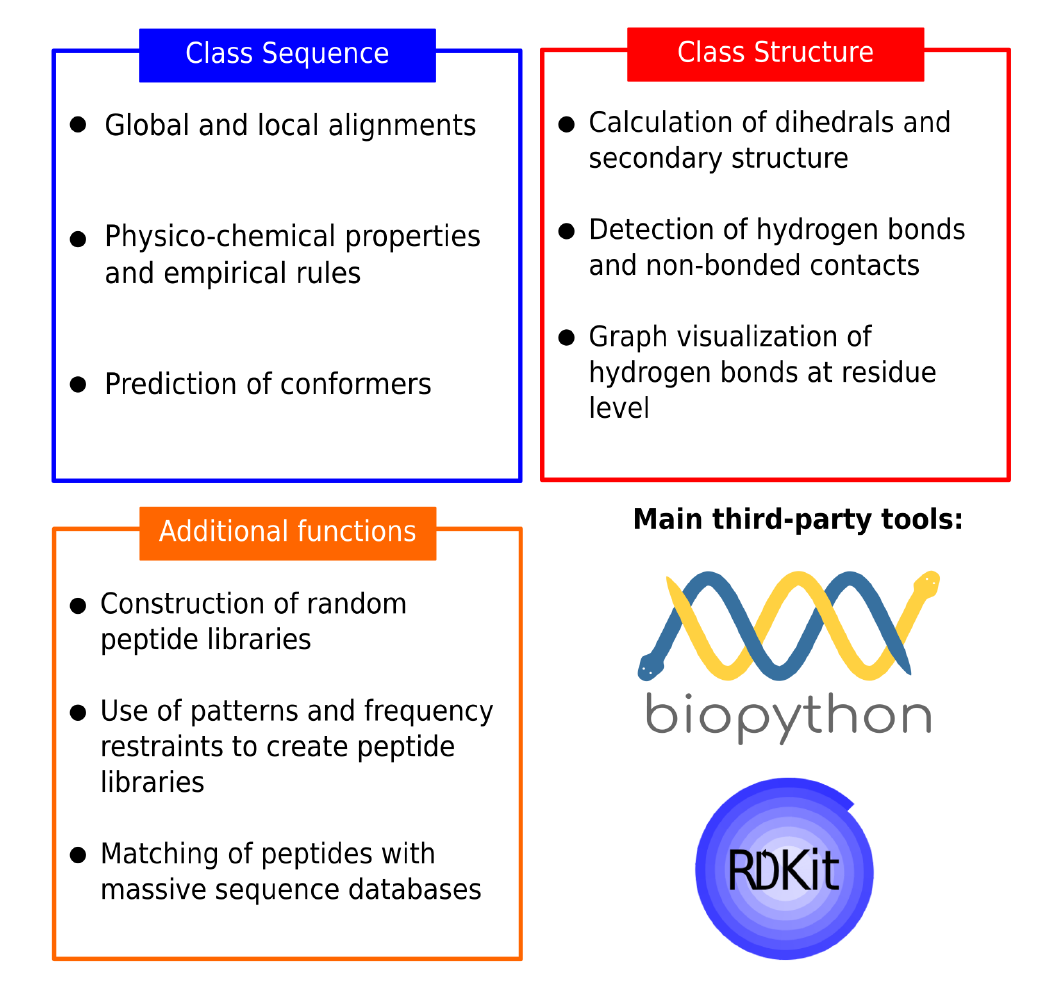
Figure 1. Summary of the PepFun modules. The modules are split into three categories: sequence-based tools, structure- based tools and additional functions. These modules rely on the Biopython functions for bioinformatics tasks, and the RDKit package for cheminformatics